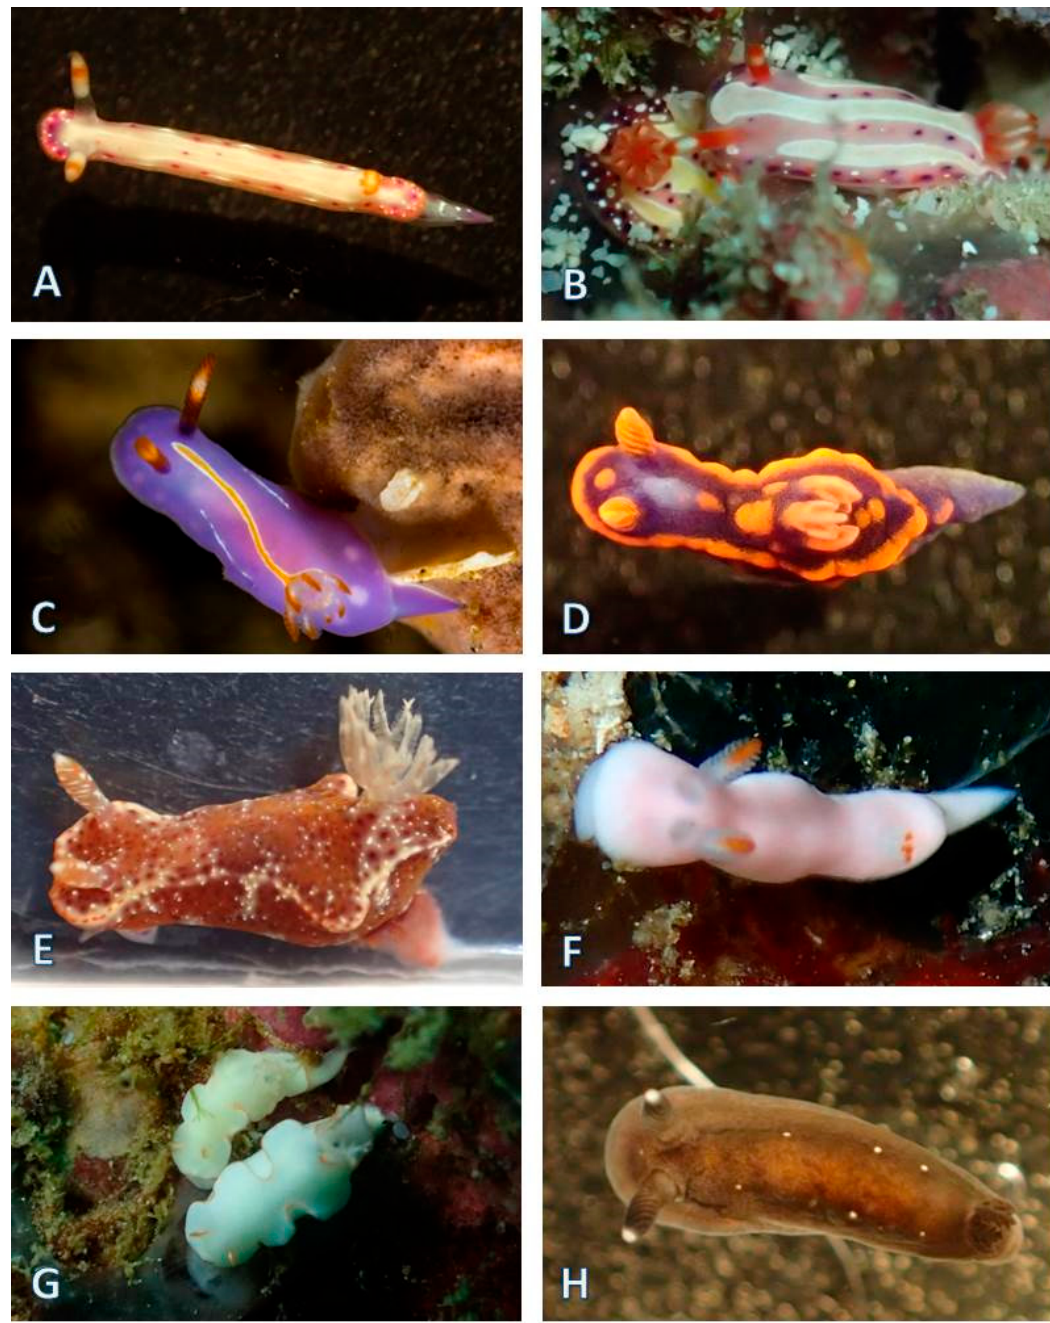
Figure 15. Nudibranchia Doridina: ( A ) Hypselodoris sp. a, Thsp1-18Ba-1; ( B ) Mexichromis aurora , Meau18Ba-1; ( C ) Mexichromis trilineata* ; ( D ) Miamira magnifica , Dorid18Ba-1; ( E ) Miamira sp. a, Misp17Ba-1; ( F ) Verconia simplex , Nosi17Ba-1; ( G ) Thorunna furtiva , Thfu18Ba-1-2; ( H ) Dendrodoris nigra , Deni18Ba-1. *Specimen not collected.